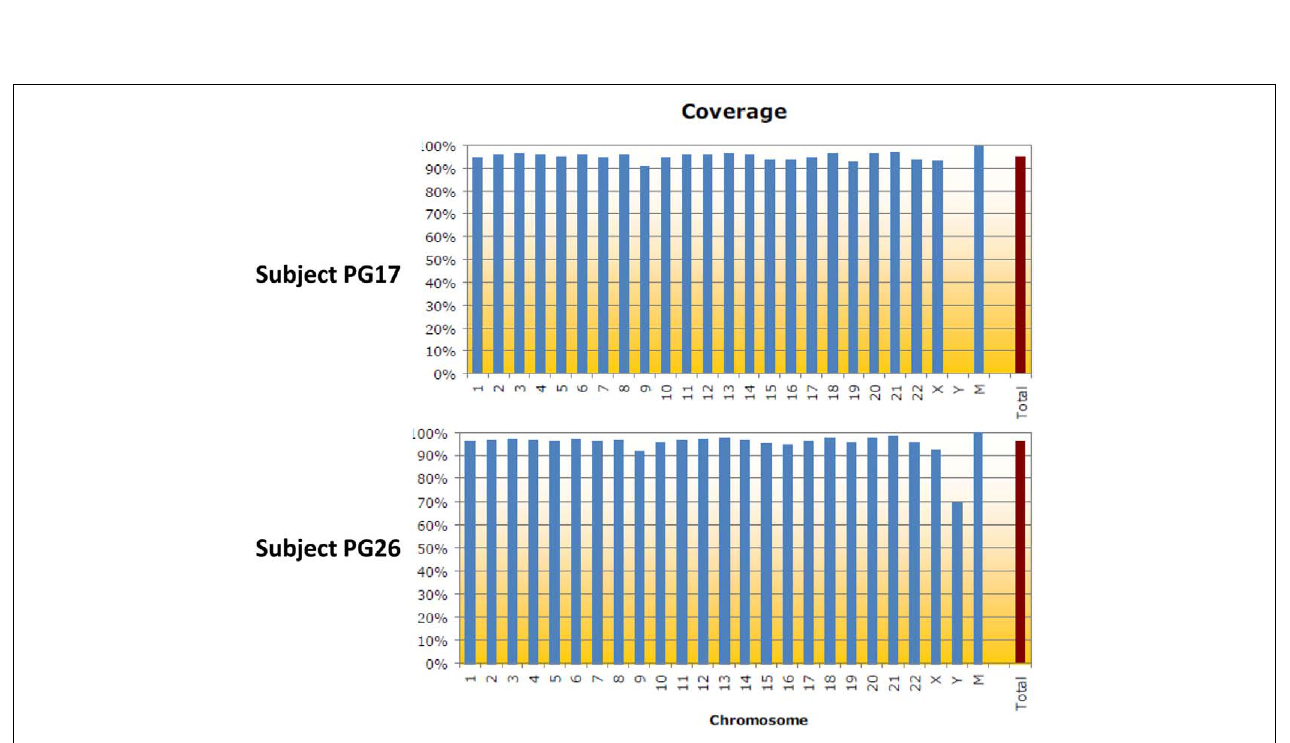
FIGUREA11 | Genomic Coverage from ELAND. Barplots show the % of genomic coverage per chromosome when the reads were mapped to HG18 using the Illumina Elander aligner.